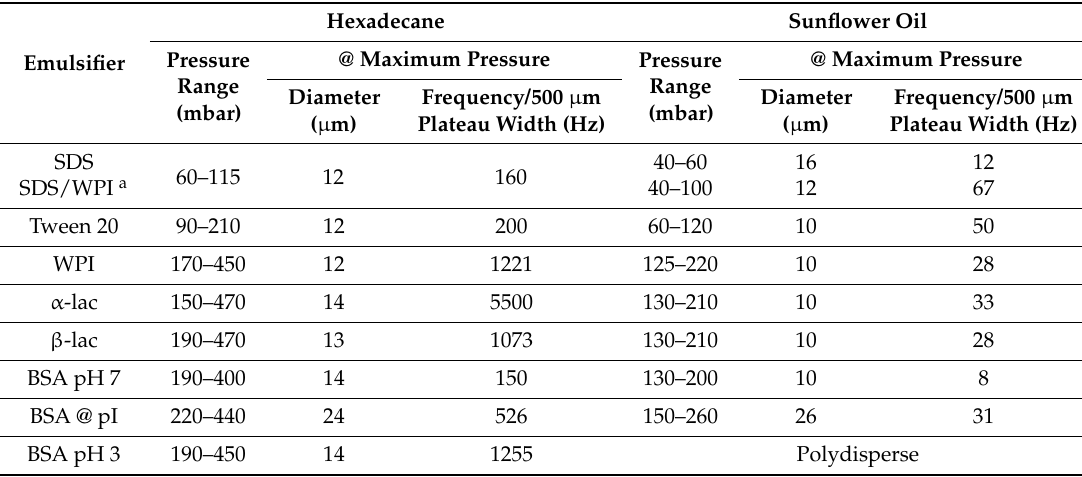
Table 1. Maximum productivity of different oil-emulsifier combinations